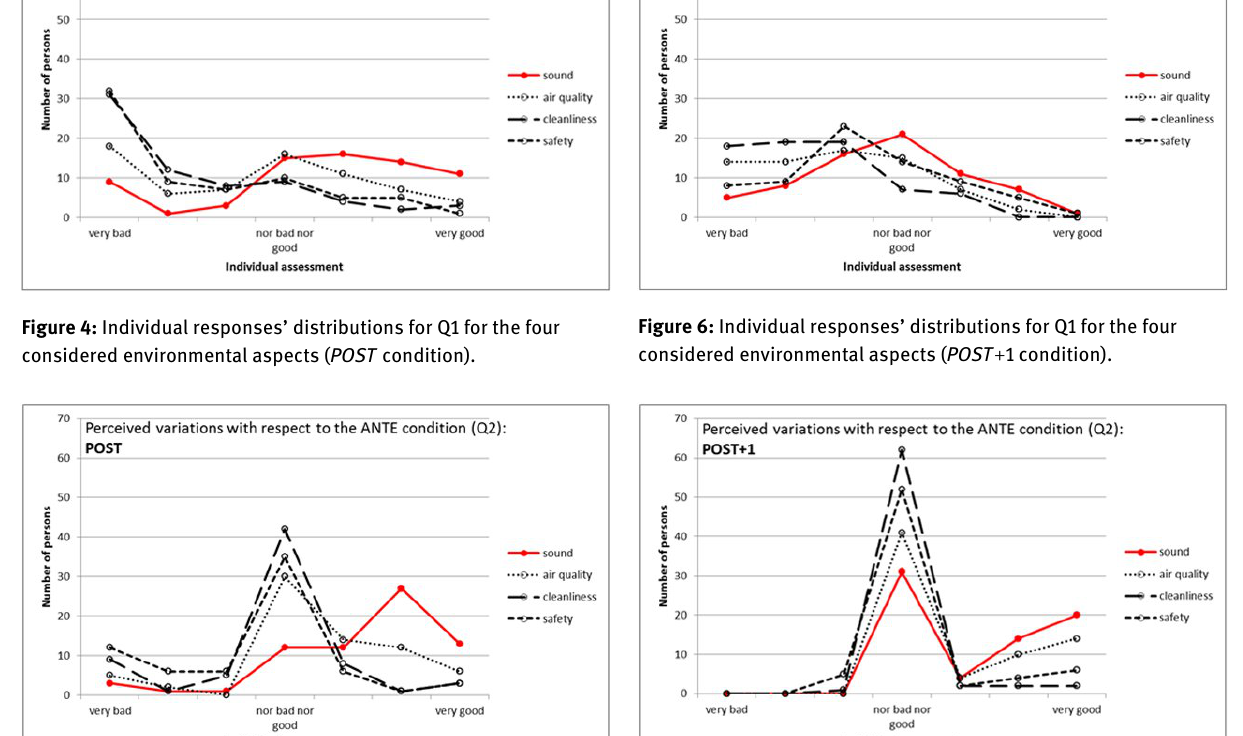
Figure 5: Individual responses’ distributions for Q2 for the four considered environmental aspects ( POST condition).